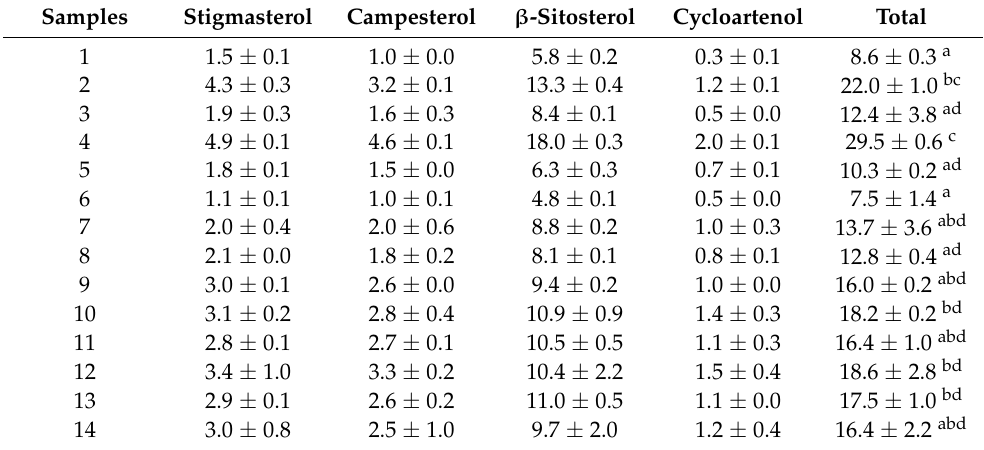
Table 2. Concentration (mg/L) of phytosterols in different espresso coffee samples. Data are expressed as mean ± stand- ard deviation, ( n = 3 technical replicates). Total levels with different upper-case letters are statistically different with α of 0.05.